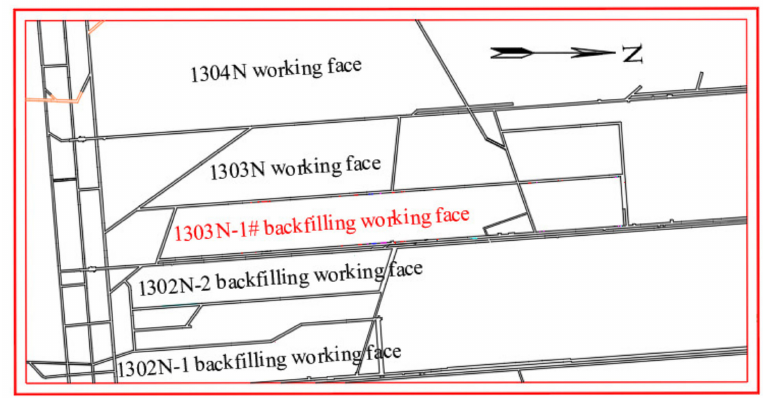
Figure 11. Layout of working face